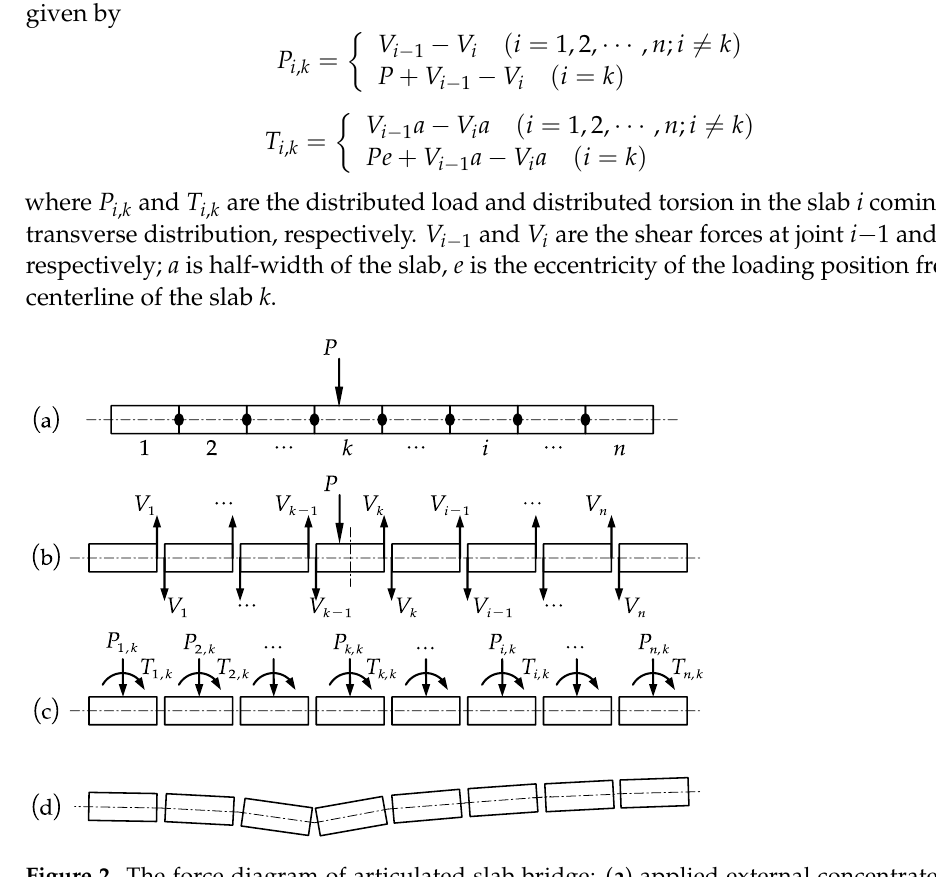
Figure 2. The force diagram of articulated slab bridge: ( a ) applied external concentrated load, ( b ) vertical shear of joints, ( c ) distribution loads of each slab, and ( d ) deflections of slabs.